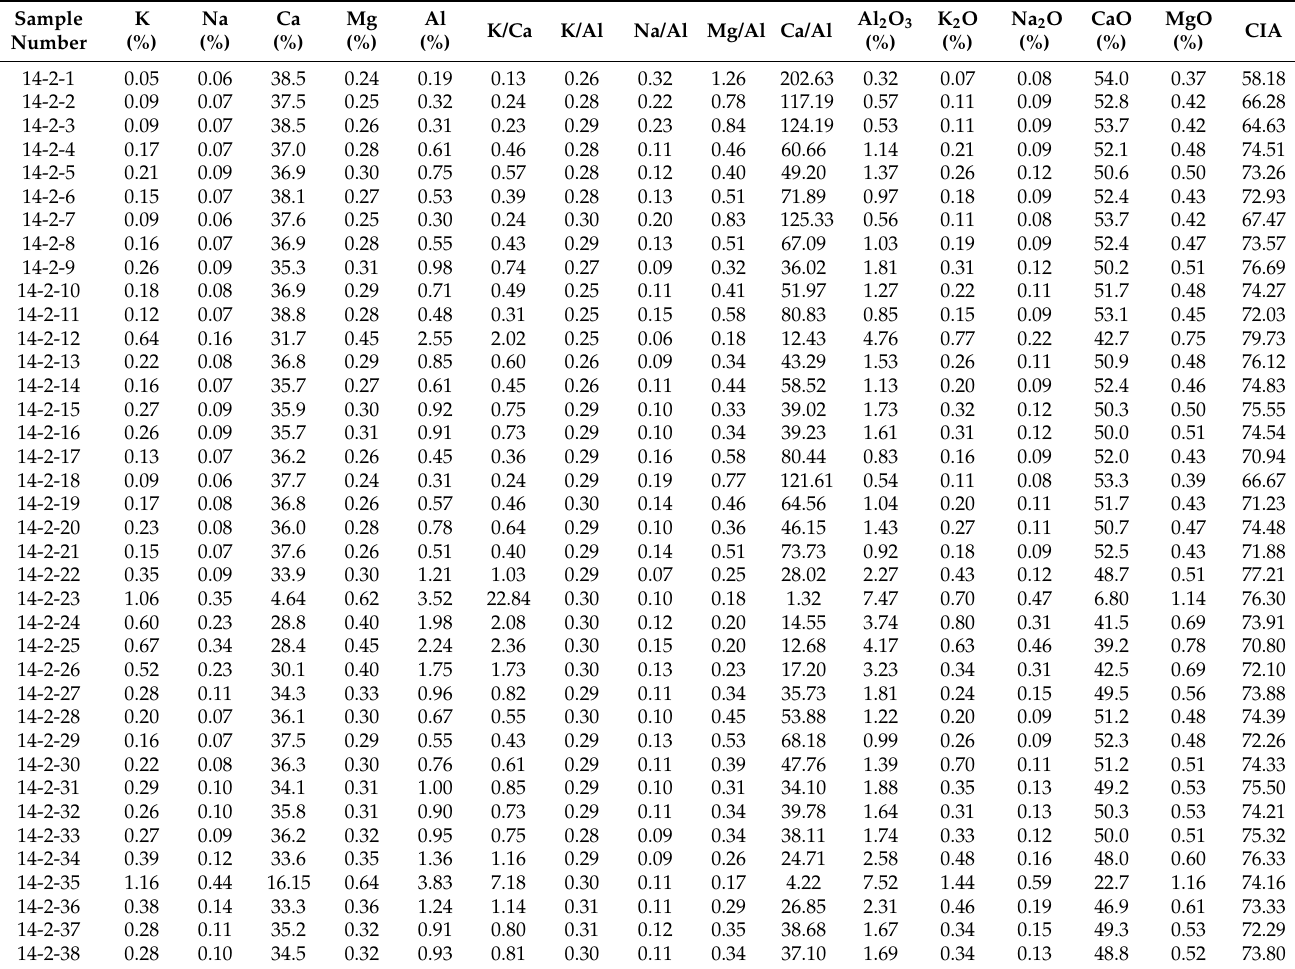
Table 2. Content and ratios of major/trace elements in calcareous tufa of Sparkling